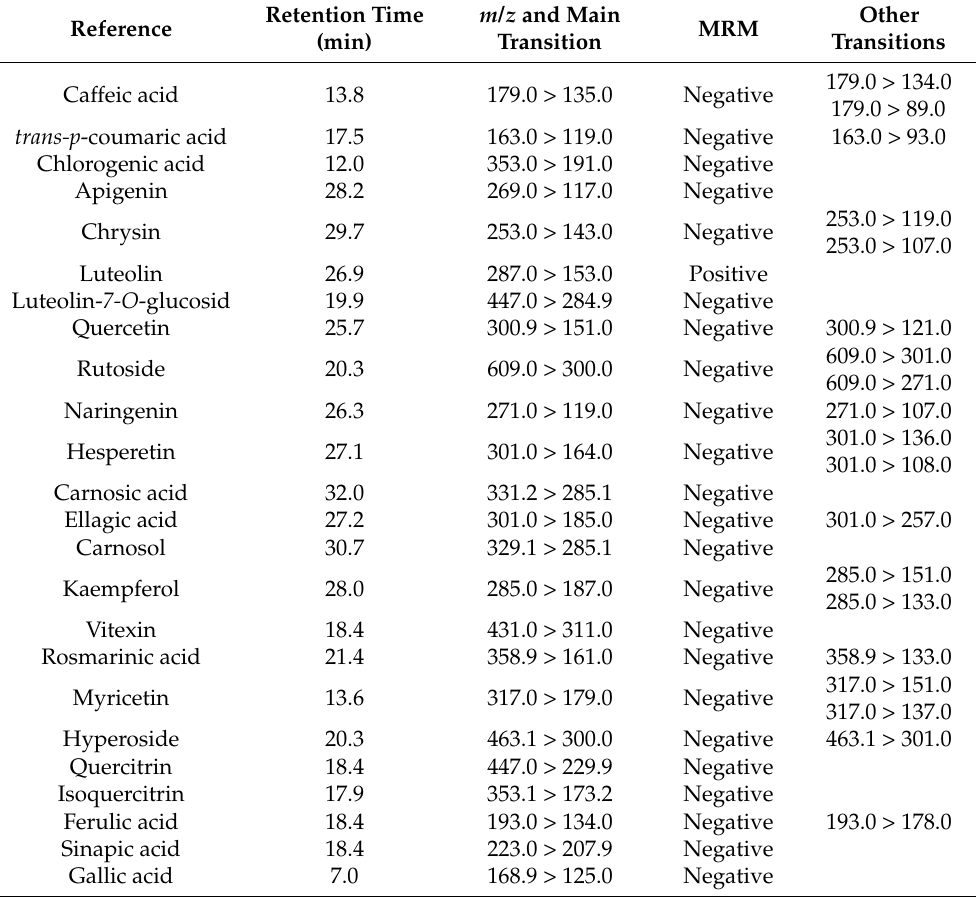
Table 7. The LC-MS quantification parameters of